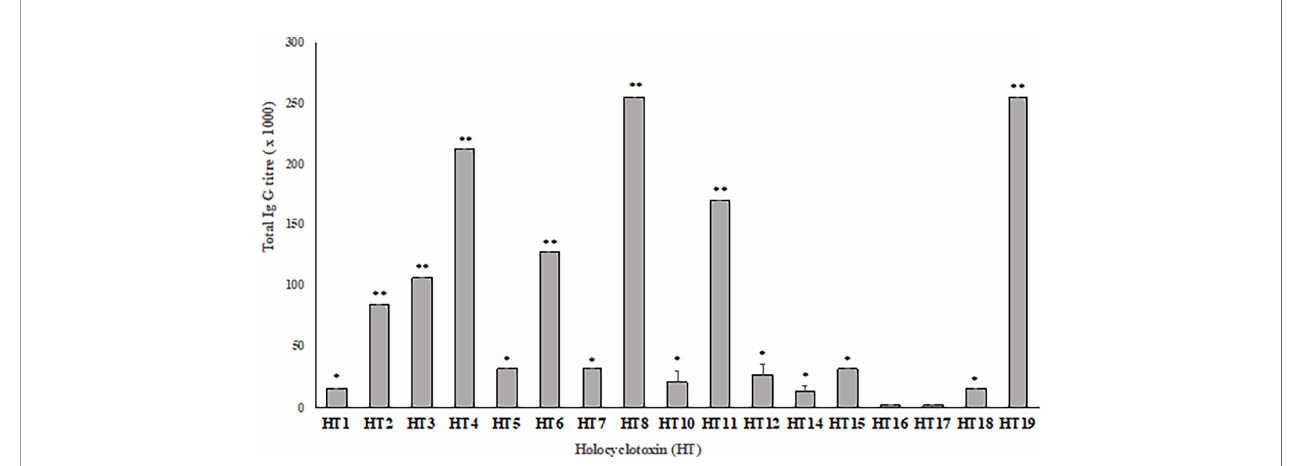
FIGURE 1 | Average IgG titer against synthetic holocyclotoxins present in three different production batches of commercial tick anti-serum (Summerland). Results displayed as Mean± SD of end point titer (n = 3). The end point titer was determined as the reciprocal of the dilution that reached the background absorbance (OD l = 450nm). Signi fi cance was determined by two-way ANOVA with a Tukey ’ s multiple comparisons post-test. ** (p < 0.05), * (p < 0.0001).